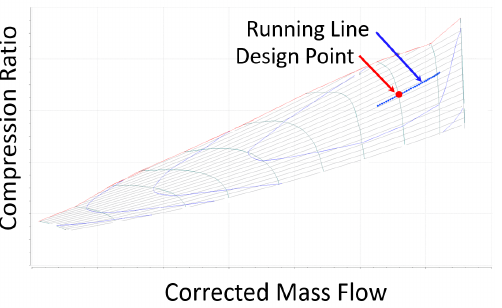
Figure 2. High-pressure compressor empirical map for the CFM56 engine sketched in Figure